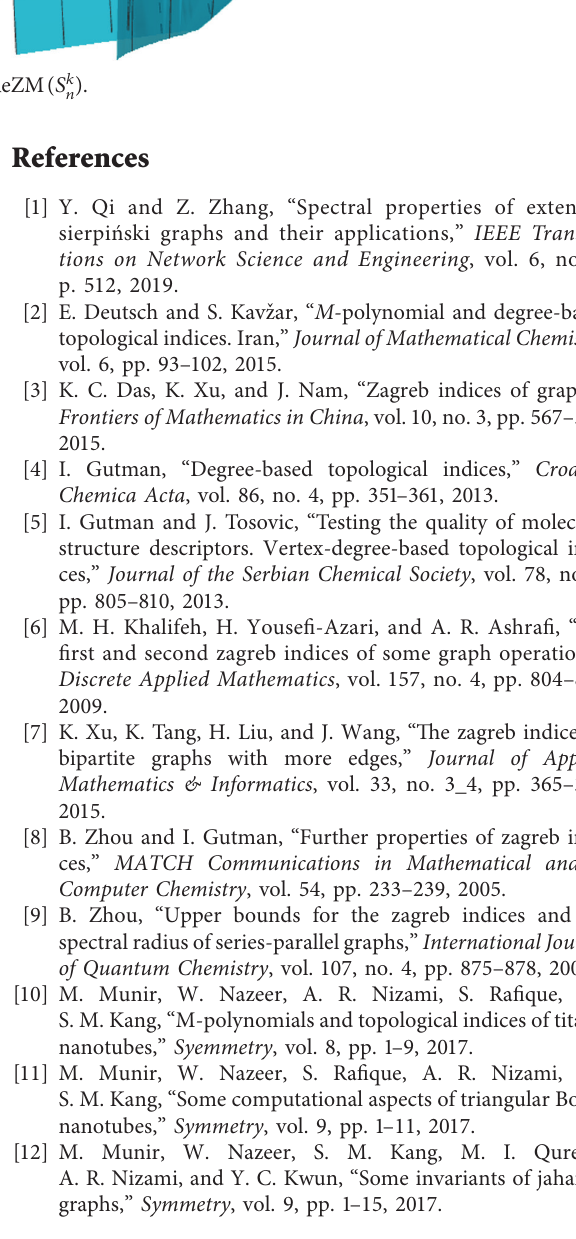
Figure 7: ReZM ( S k